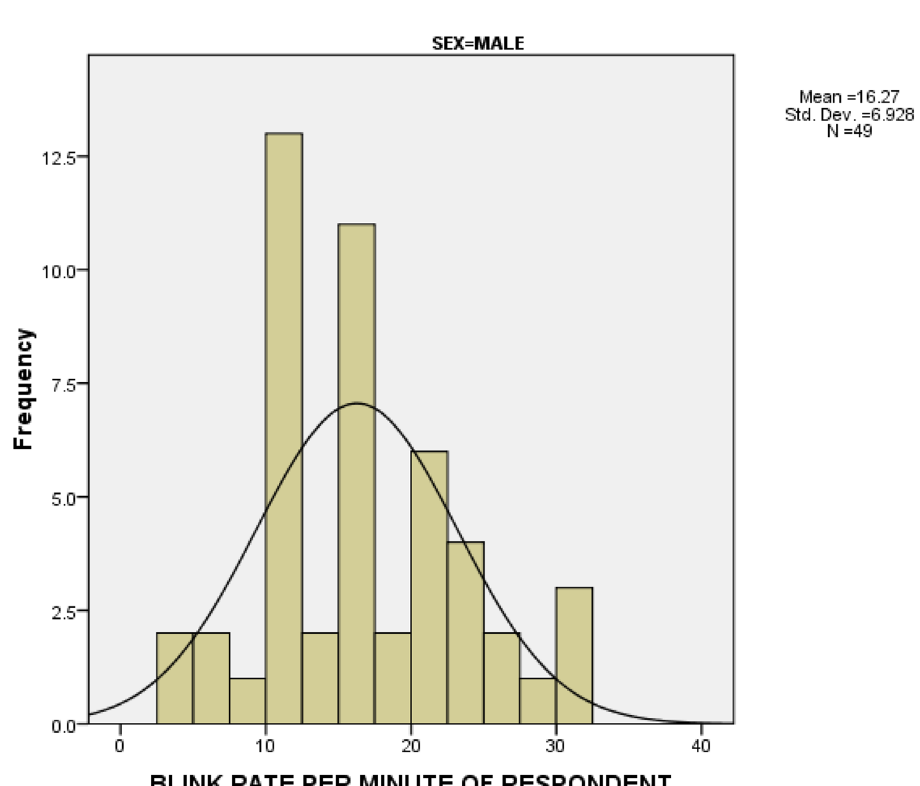
Figure 2. Distribution of blinking rate among